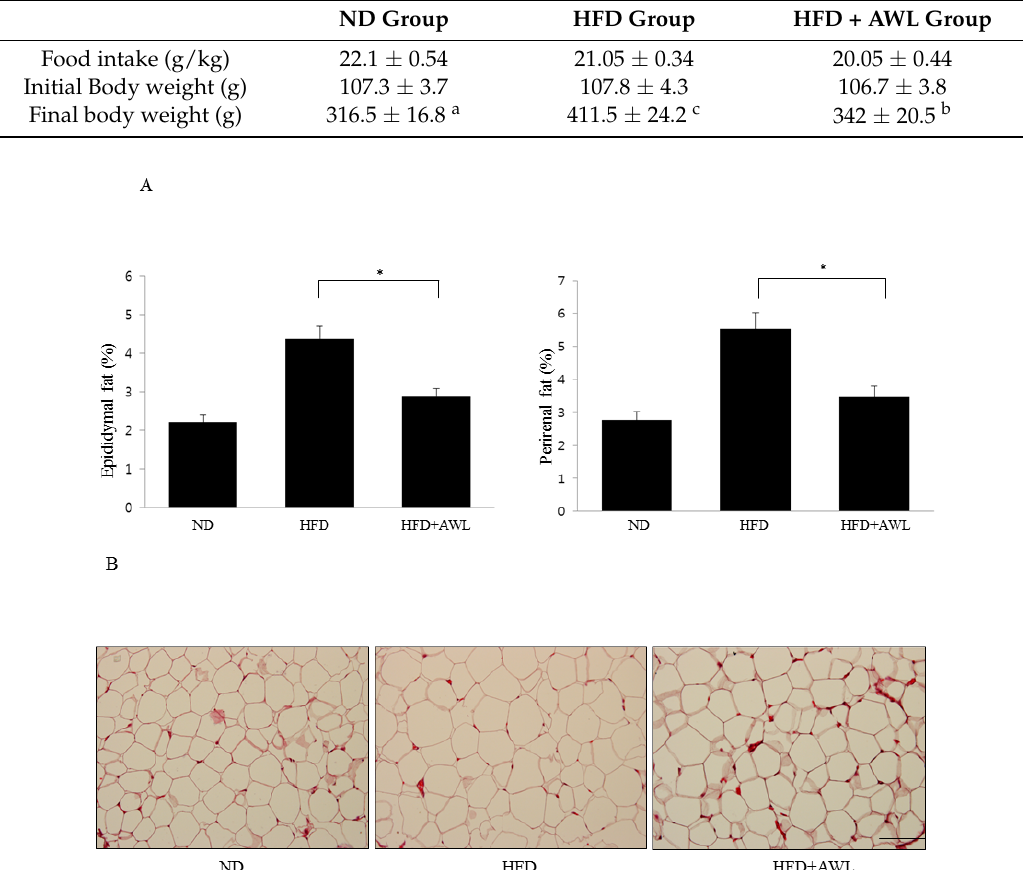
Figure 4. AWL ameliorates adiposity in HFD ‐ induced obese rats. Rats were fed a normal diet or high ‐ fat diet for five weeks in the presence (150 mg/kg/day) or absence of AWL ( n = 10). ( A ) the weight of perirenal and epididymal fat was significantly reduced by AWL treatment. * p < 0.05; ( B ) histological analysis of epididymal adipose tissue after staining with Haematoxylin and Eosin (H&E) followed by microscopy analysis. Scale bar is 100 μ m.